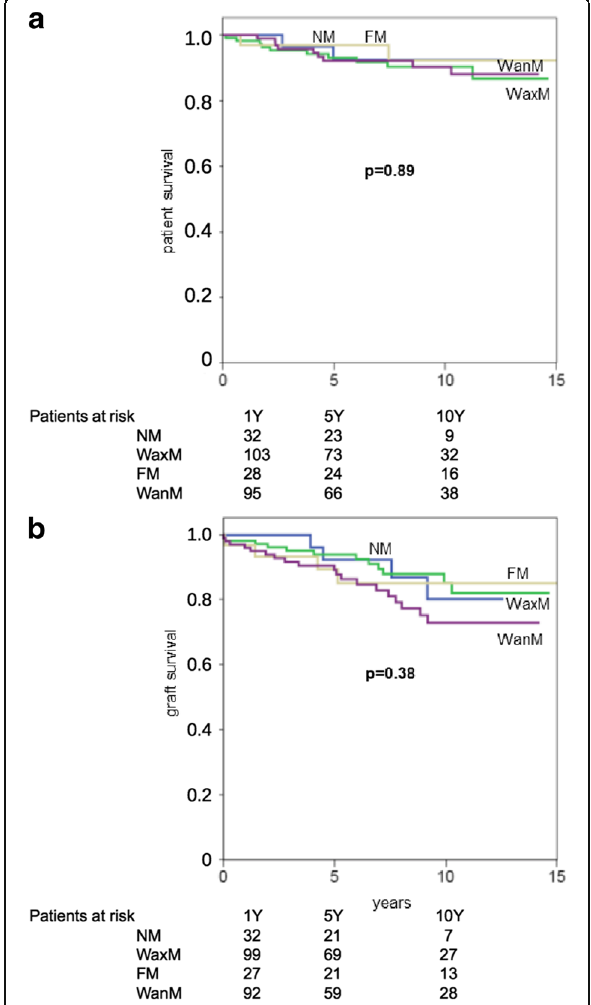
Fig. 4 a Patient- and ( b ) graft survival after living donor kidney transplantation (LDKT) in recipients, grouped according to the four main moon phases: new moon (NM); waxing moon (WaxM); full moon (FM) and waning moon (WanM). The full moon phase , which, according to medical astrology, should be avoided for operations, did not show a worse course than other moon